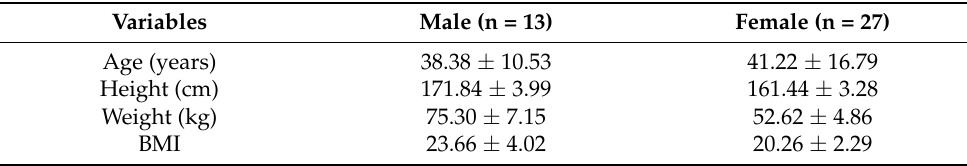
Table 1. General characteristics of the